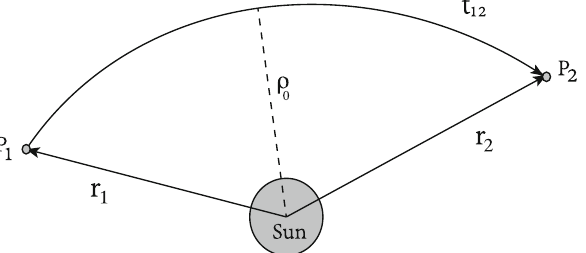
Fig. 7 Scheme for the gravitational time delay effect. A light signal is emitted from P 1 at r 1 to P 2 at r 2 and returns to P 1 . Here, ρ 0 is the closet approach to the Sun, and t 12 is the time interval between emission and return of the pulse as measured by a clock on